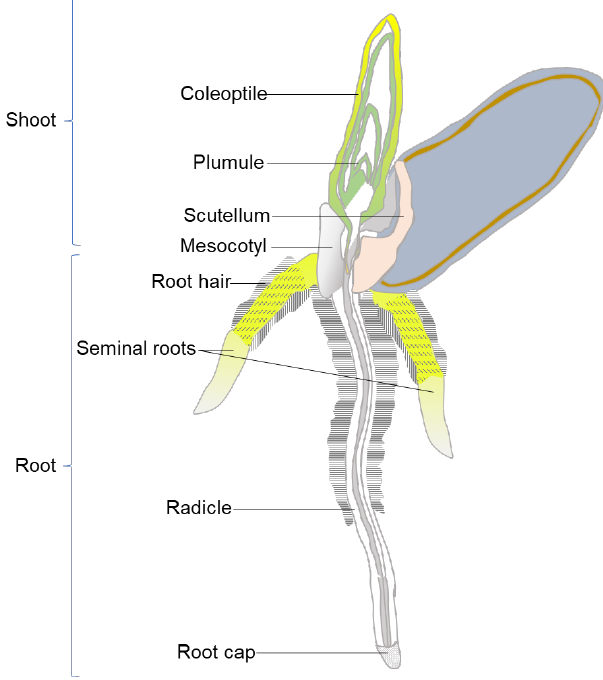
Figure 1. Annotated diagram of germinating 4 day old wheat grain. The kernel is showing